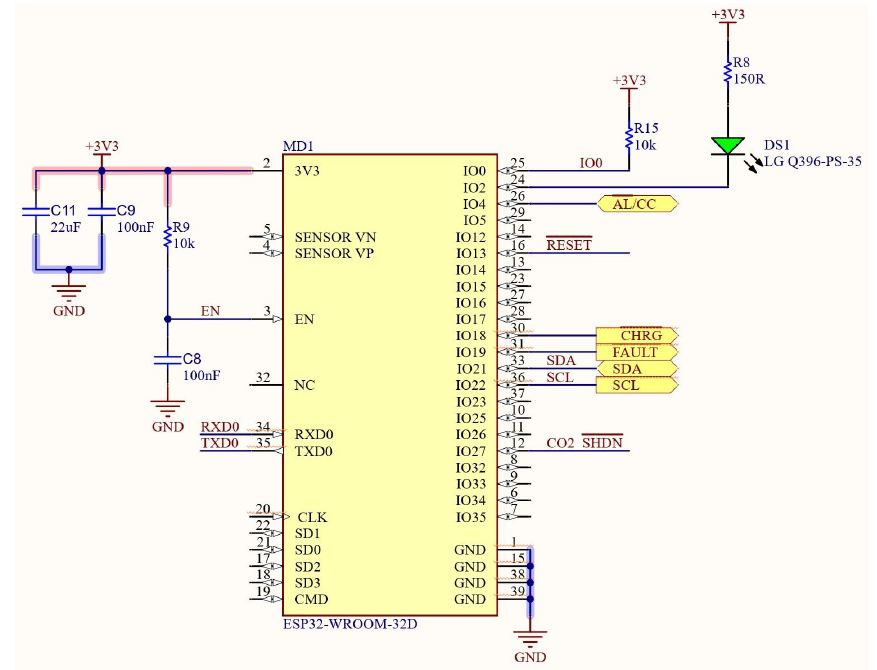
Figure 3. Sketch of the connections of